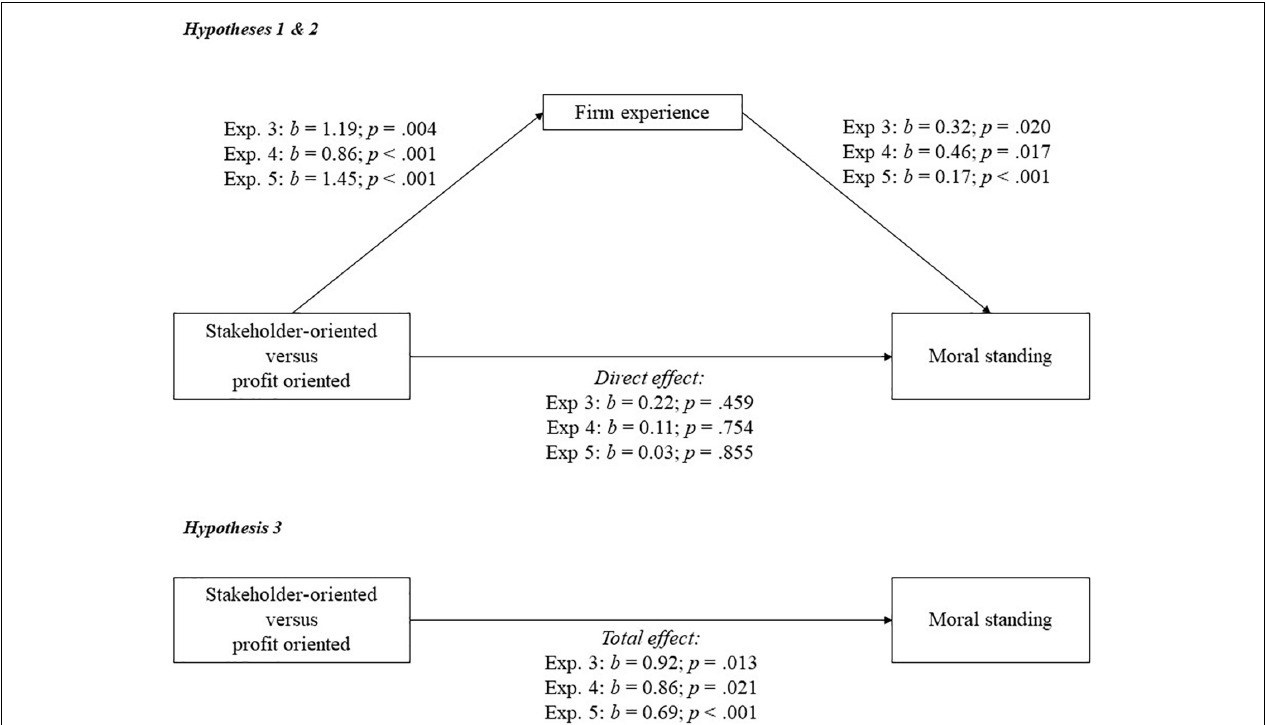
FIGURE 1 | A model of mediation indicating that the relationship between business orientation and moral standing goes via experience attributions to the firm in experiments 3, 4, and 5.